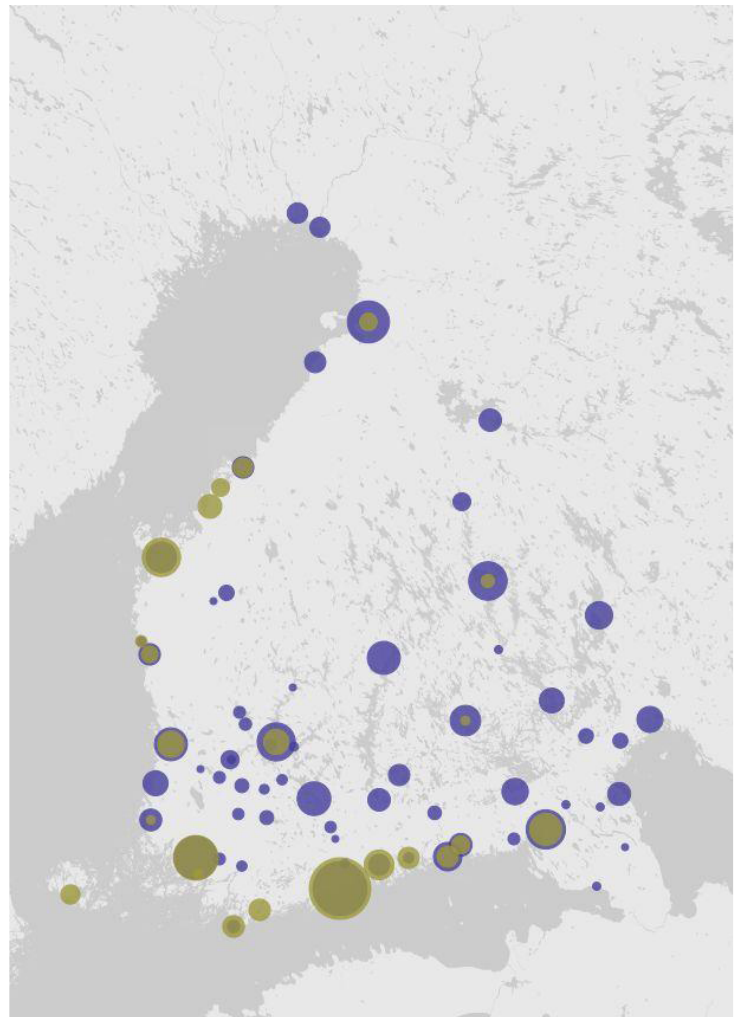
Fig. 10 Newspapers published in Swedish and in Finnish in the year 1920: Swedish- language newspapers are in yellow, Finnish-language newspapers in blue. Size denotes number of